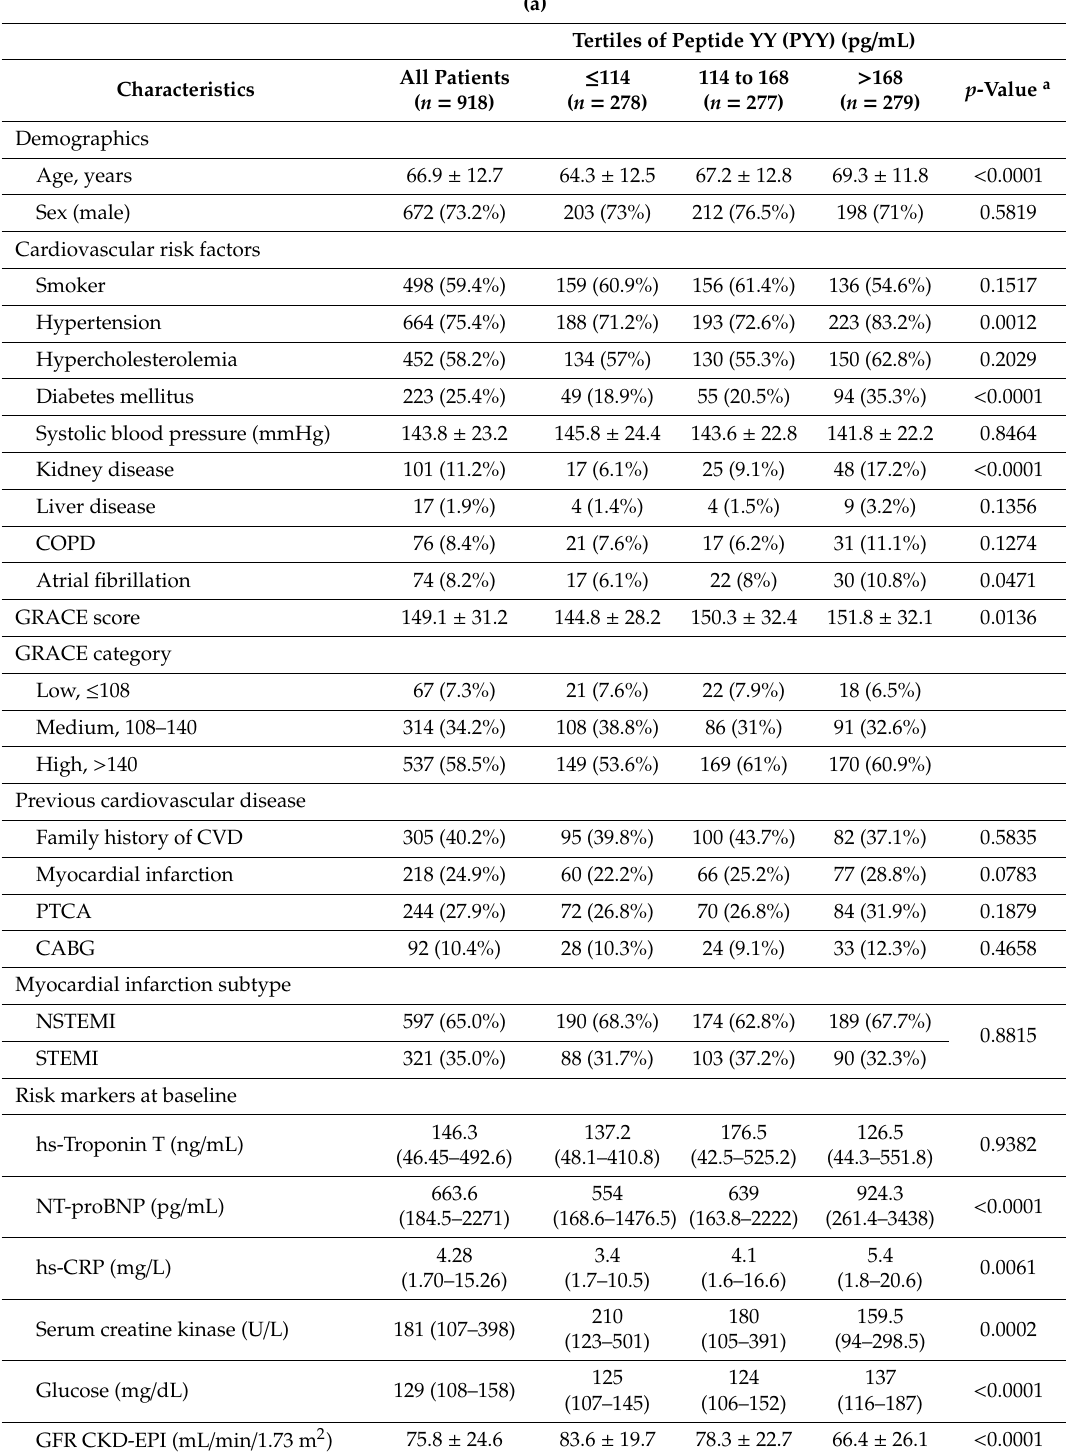
Table 1. ( a ) Baseline characteristics. ( b ) Baseline